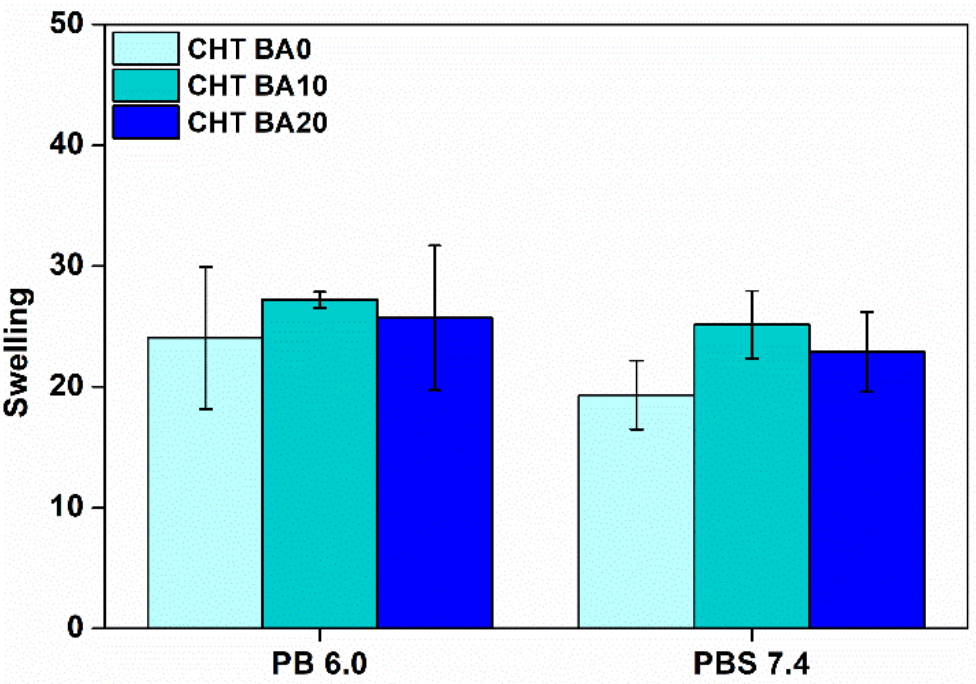
Figure A2. Swelling capacity of chitosan-boric acid scaffolds in buffer solutions with different pH (PB 6.0, PBS 7.4) after 24 h.